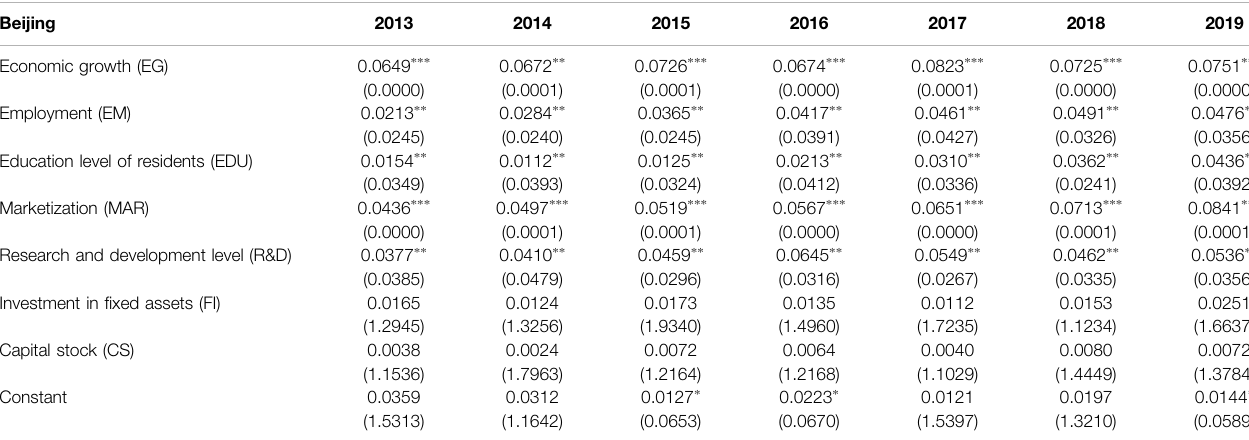
TABLE 12 | Driving force of Beijing health tourism industry convergence.